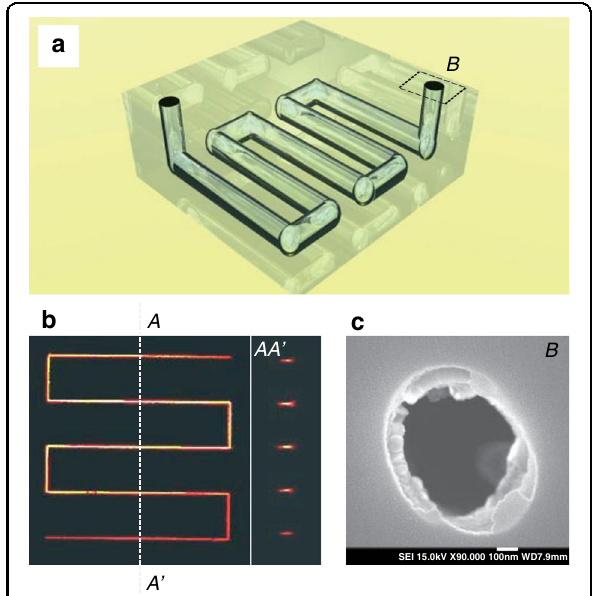
Fig. 12 Fabrication of 3D network channels inside sapphire by femtosecond laser writing followed by etching in a 10% HF water solution 36 . a The 3D pattern of micro-channels in sapphire. b Confocal sectioning of rhodamine photoluminescence in sapphire. The pattern of micro-channels is at a depth of 10 μ m. The horizontal length of the channel was 40 μ m. c SEM image of channel ’ s cross- section (section B shown in Fig. 12a), scale bar: 100 nm. Reproduced with permission from ref. 36 , ©2006 WILEY-VCH Verlag GmbH &